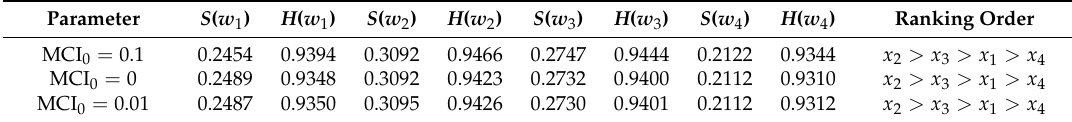
Table 2. Computation results and ranking orders for different values of parameters MCI 0 with ϕ =